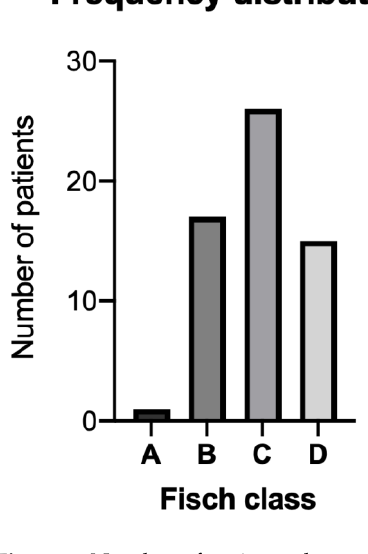
Figure 2. Number of patients clustered according to Fisch classification. A = 1, B = 17, C = 26, and D = 15 patients. D = 15